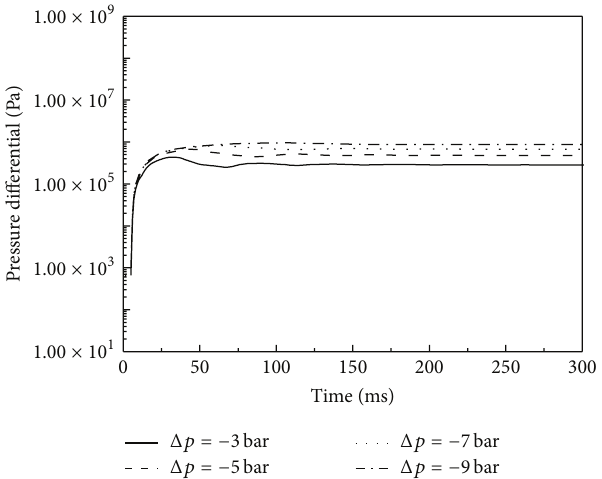
Figure 6: Pressure differential on the wall of hot gas duct.